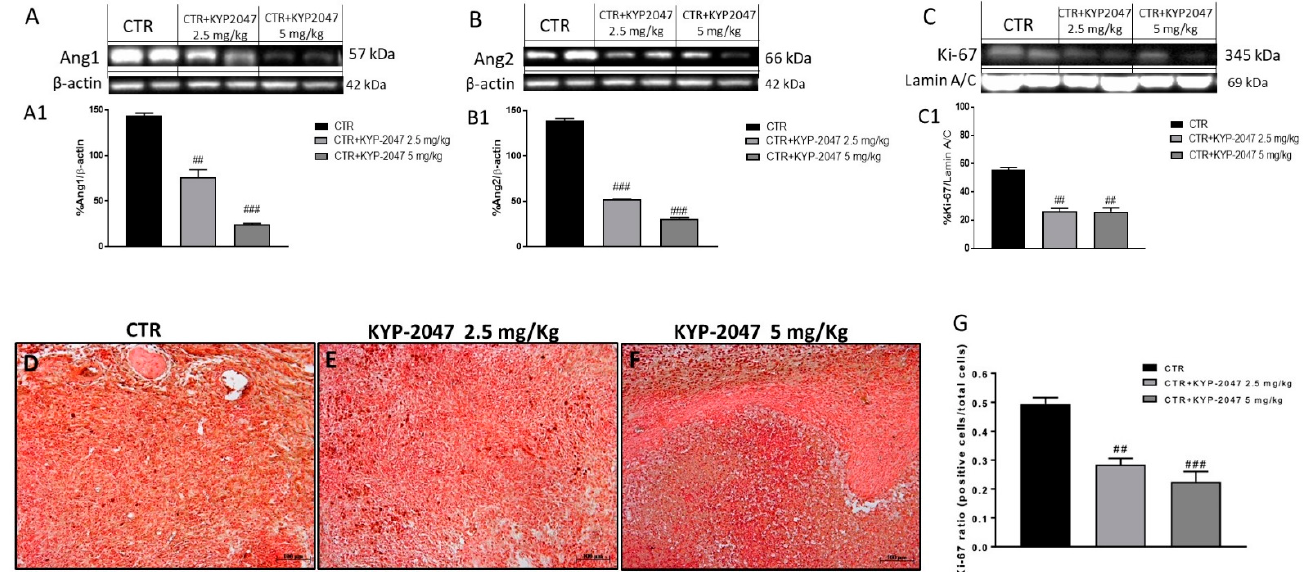
Figure 4. Effect of KYP-2047 on Ang1, Ang2 and Ki-67 expression. The blots revealed a significant increase of Ang1 and Ang2 expression in the control group while the treatment with KYP-2047 at doses of 2.5 mg/kg and 5 mg/kg significantly reduced their expression ( A , B ). Sections were observed and photographed at 10× magnification Moreover, the panel C revealed a significant increase of Ki-67 in the control group while the treatment with KYP-2047 at doses of 2.5 mg/kg and 5 mg/kg significantly decreased its expression. The data for Ki-67 was confirmed also by immunohistochemistry ( D – F ). Data are representative of at least three independent experiments. ( A ) ## p < 0.01 vs. CTR; ### p < 0.001 vs. CTR; ( B ) ### p < 0.01 vs. CTR; ( C ) ## p < 0.01 vs. CTR. ( G ) ## p < 0.01 vs. CTR; ### p < 0.001 vs. CTR.